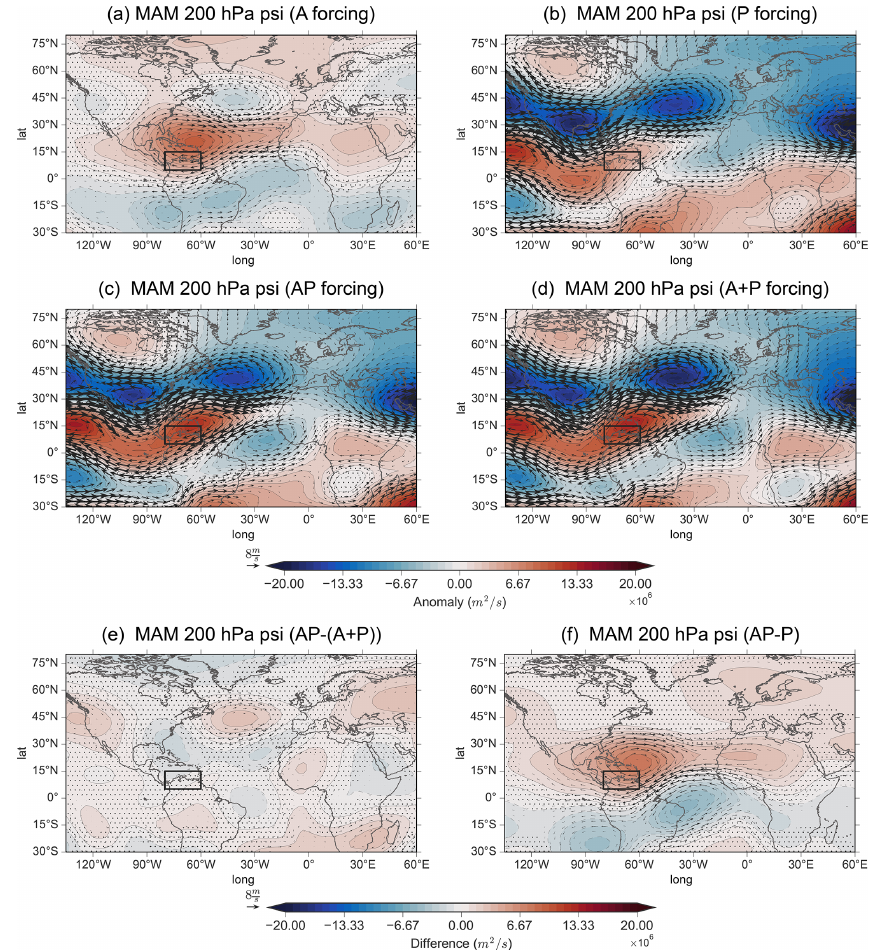
Figure 6. MAM 200hPa streamfunction (shading) and non-divergent wind (vector) analysis for the response to the different forcings from the Atlantic (a) , Pacific (b) , and Atlantic plus Pacific combined (c) , as well as the linear addition of the Pacific and Atlantic contributions (d) . The difference between the linearly forced response (A + P) and the combined response (AP simultaneously) is represented in panel (e) , while the Atlantic contribution (f) is derived as the difference between ( c , AP forcing) and ( b , P forcing). Stippling in panels (a) – (c) represents anomalies that are not statistically significantly different from climatology, stippling in panel (e) represents differences that are not statistically significantly different between the AP forcing (c) run and the linear combination of the Atlantic and Pacific (A + P, d ), and stippling in panel (f) represents differences that are not statistically significantly different from the P forcing run, all at the 95% level using a two-tailed Monte Carlo test. The black box represents the RWS index over the Caribbean region. Wind vectors in panels (e) and (f) represent statistically significantly different winds from (A+P) and (P),